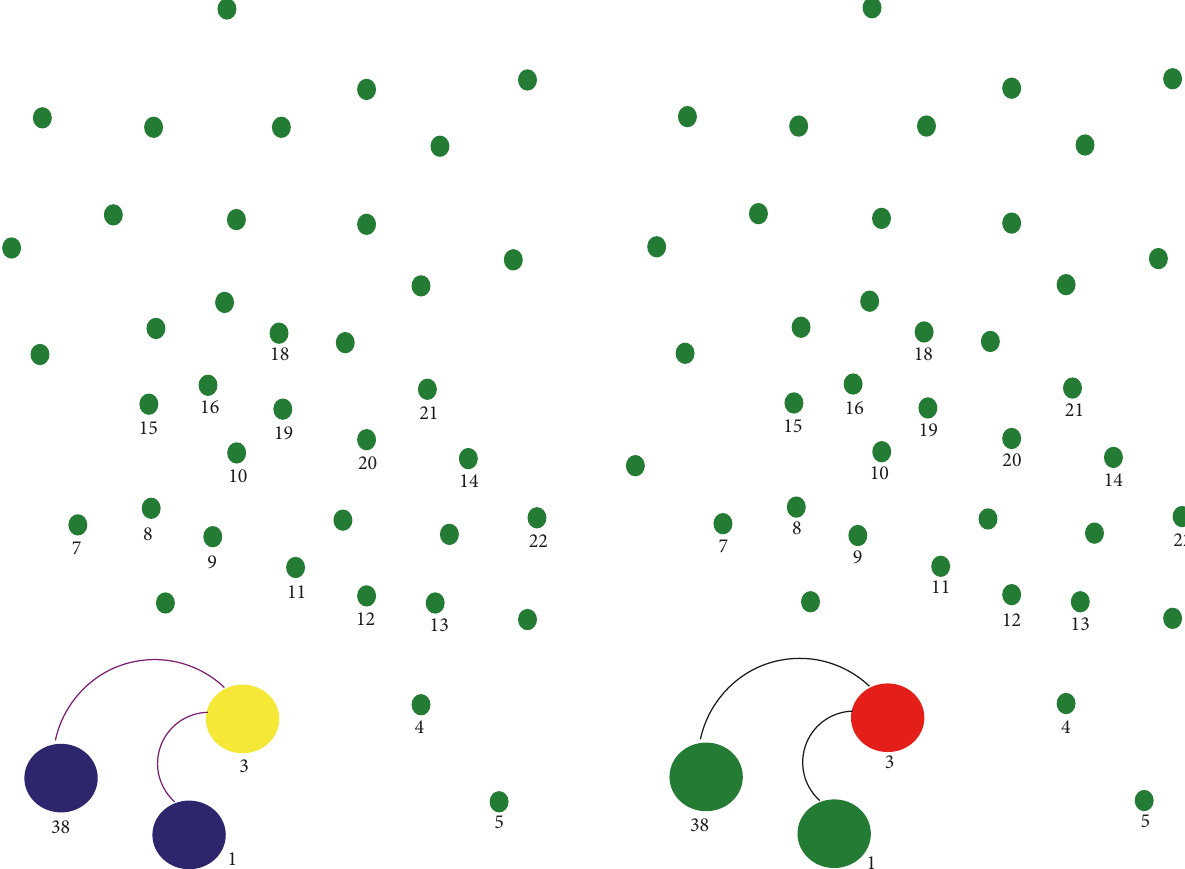
Figure 5: Nodes 1 and 38 are idle and node 3 processes